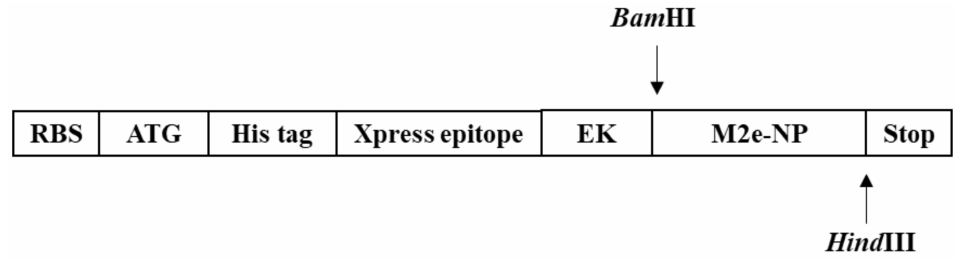
Figure 1. Gene arrangement in pRSET B-M2e-NP plasmid. The fusion gene was flanked by a histidine tag, Xpress epitope and enterokinase (EK) cleavage site on its 5 (cid:48) -end. The Bam HI and Hind III restriction sites were located at its 5 (cid:48) - and 3 (cid:48) -end,